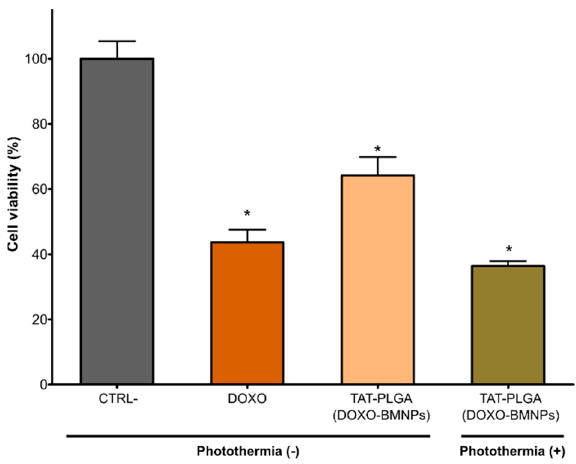
Figure 7. Cytotoxicity in HepG2 cell line cell line following treatment with culture medium (control), DOXO (30 μ g/mL), and TAT–PLGA(DOXO-BMNPs) (containing 300 μ g/mL BMNPs and 30 μ g/mL DOXO) in the absence or presence of photothermia. Data represent the means ± SEM of three independent experiments performed in triplicate; p ≤ 0.05 (*).